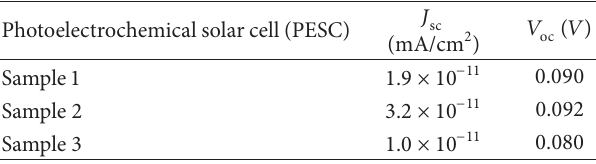
Table 2: Value of 𝐽 /aluminium under light illumination of 100mW/cm 2 LiClO 4